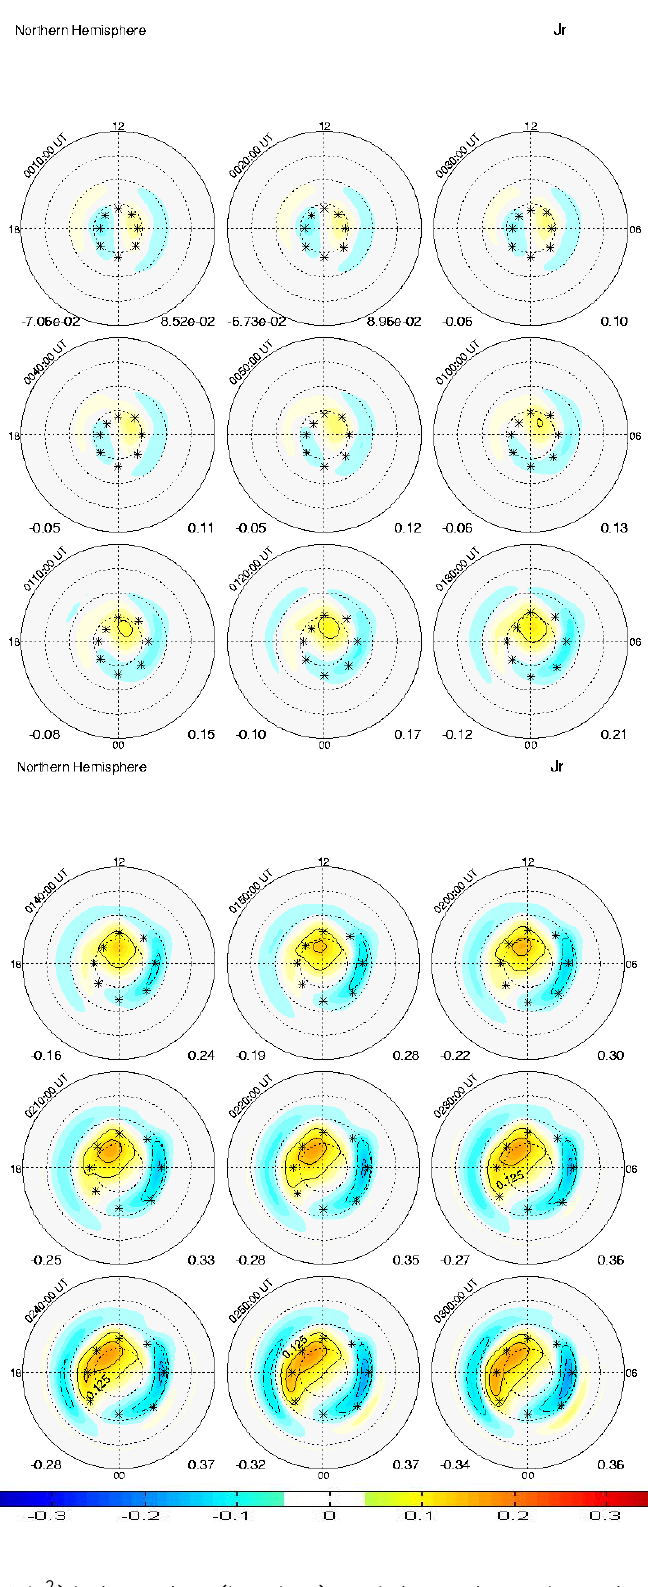
Fig. 3. Field-aligned currents ( µ A/m 2 ) in the Northern (i.e. winter) Hemisphere under varying northward and duskward IMF. The color coding shows the field-aligned current densities and the contours indicates the equal current density. The asterisks mark the open/closed field line